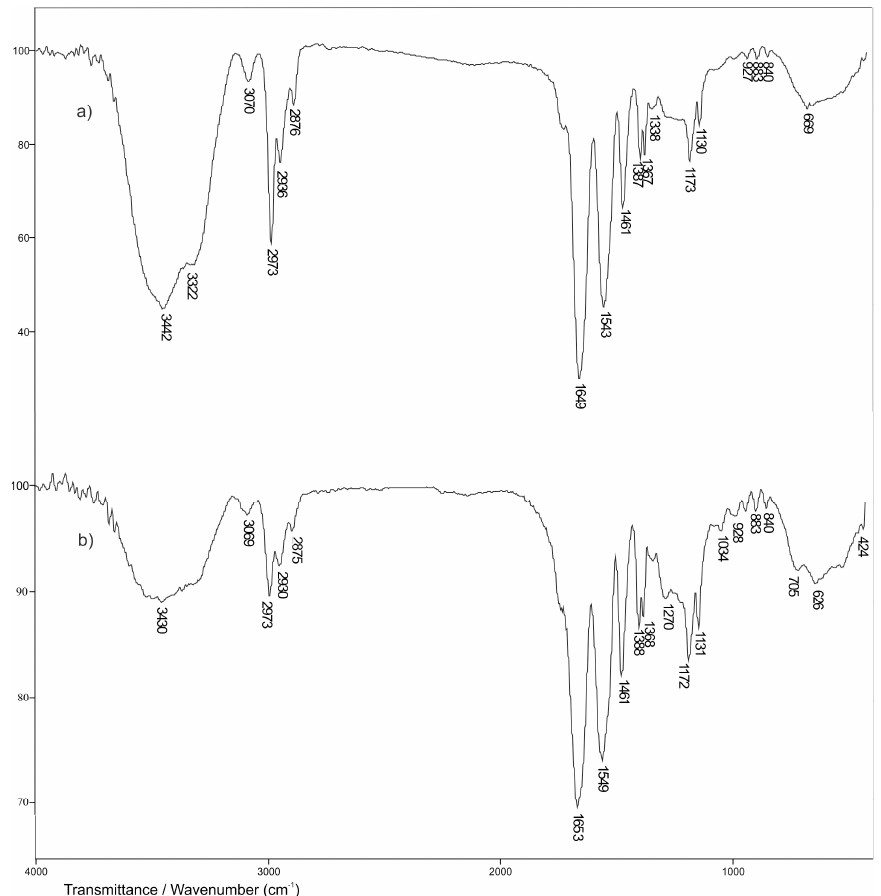
Figure 10. The FTIR spectra: ( a ) copolymer p(NiPMAm/NiPAm), sample 10/90/2 and ( b ) matrix system of p(NiPMAm/NiPAm) with incorporated inclusion complex of curcumin:2 ‐ hydroxypropyl ‐β‐ cyclodextrin.